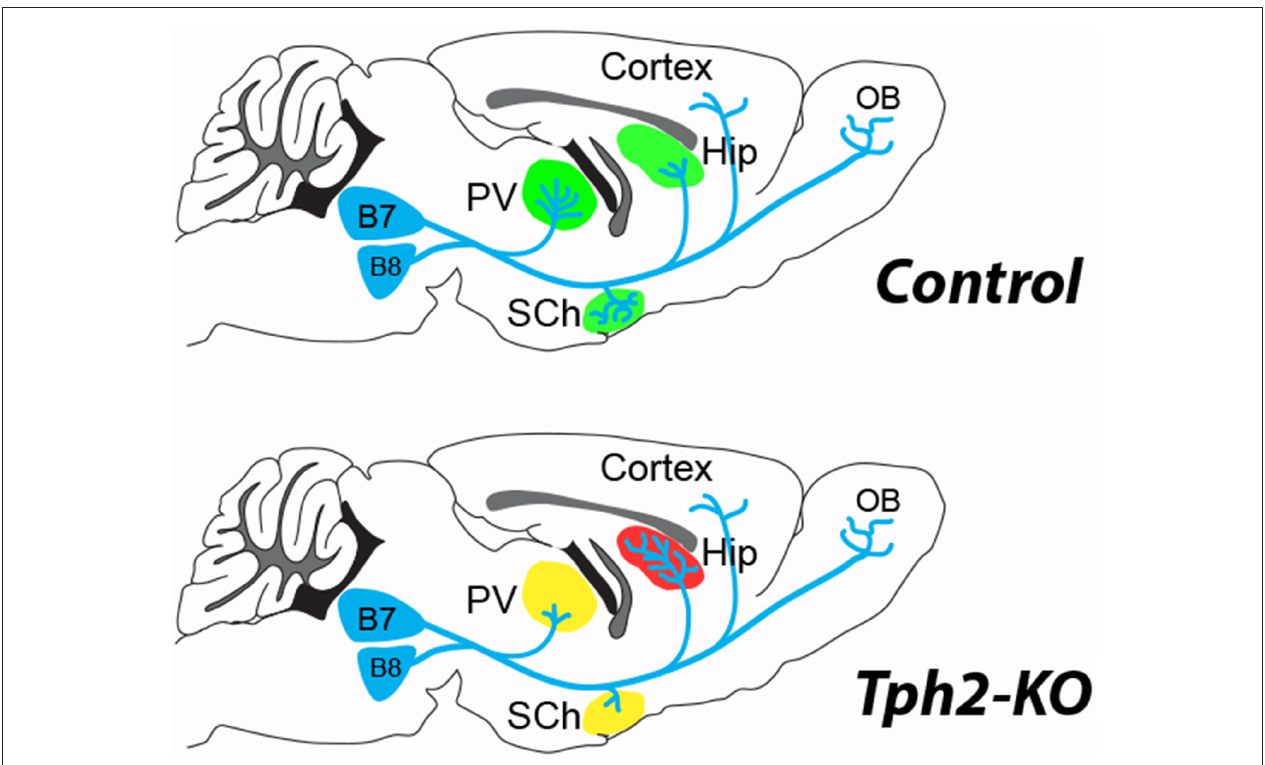
FIGURE 1 | 5-hydroxytryptamine (5-HT)-depletion in the tryptophan hydroxylase 2 (Tph2)-KO mouse modifies the terminal innervation of 5-HT neurons from dorsal raphe, B7 and median raphe, B8 (Migliarini et al., 2013). The green shading shown in the control brain, corresponds to areas where modified 5-HT innervation was observed in the Tph2-KO mice (red, increased; yellow, decreased). An increased density of 5-HT terminals (red shading) was noted in the hippocampus (Hip) coinciding with a decreased innervation (yellow shading) of the thalamic paraventricular (PV) nucleus and the suprachiasmatic (SCh) nucleus. No difference in 5-HT fiber density was observed in the cortex or the olfactory bulb (OB) of the Tph2-KO. Similar observations were made after adult knockdown of Tph2 (Pratelli et al.,